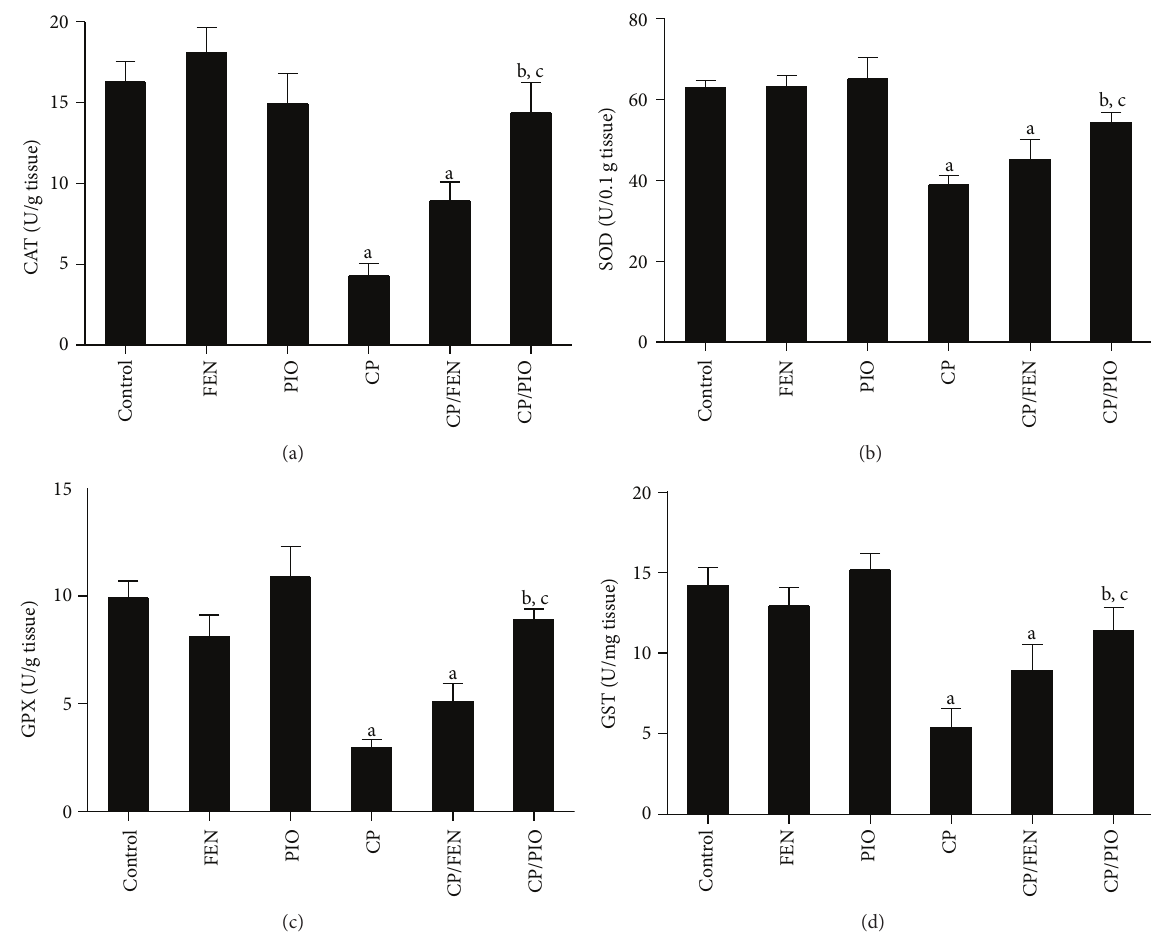
Figure 2: Effect of fenofibrate (FEN) and pioglitazone (PIO) on hepatic antioxidant enzyme levels in cyclophosphamide (CP)-treated rats. CAT: catalase, SOD: superoxide dismutase, GPX: glutathione peroxidase, GST: glutathione S -transferase. Values are representation of 8 observations as means ± SEM. Results are considered significantly different when 𝑃 < 0.05. a Significant difference compared to control, b significant difference compared to CP group, c no significant difference compared to control.